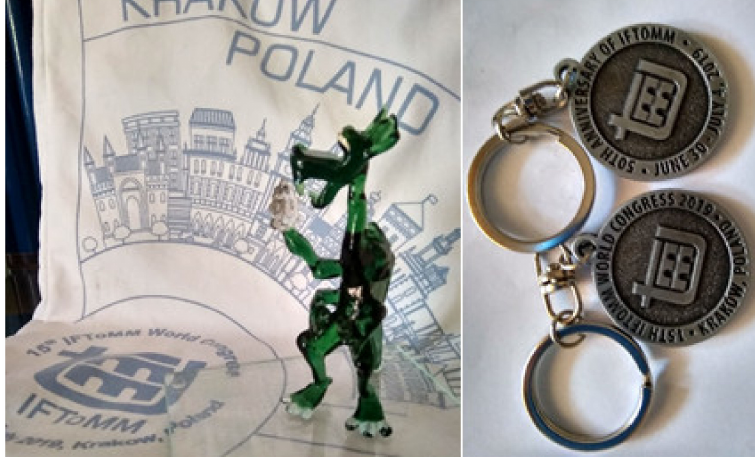
Figure 8. Gifts at the 2019 IFToMM World Congress as memories of the IFToMM anniversary.